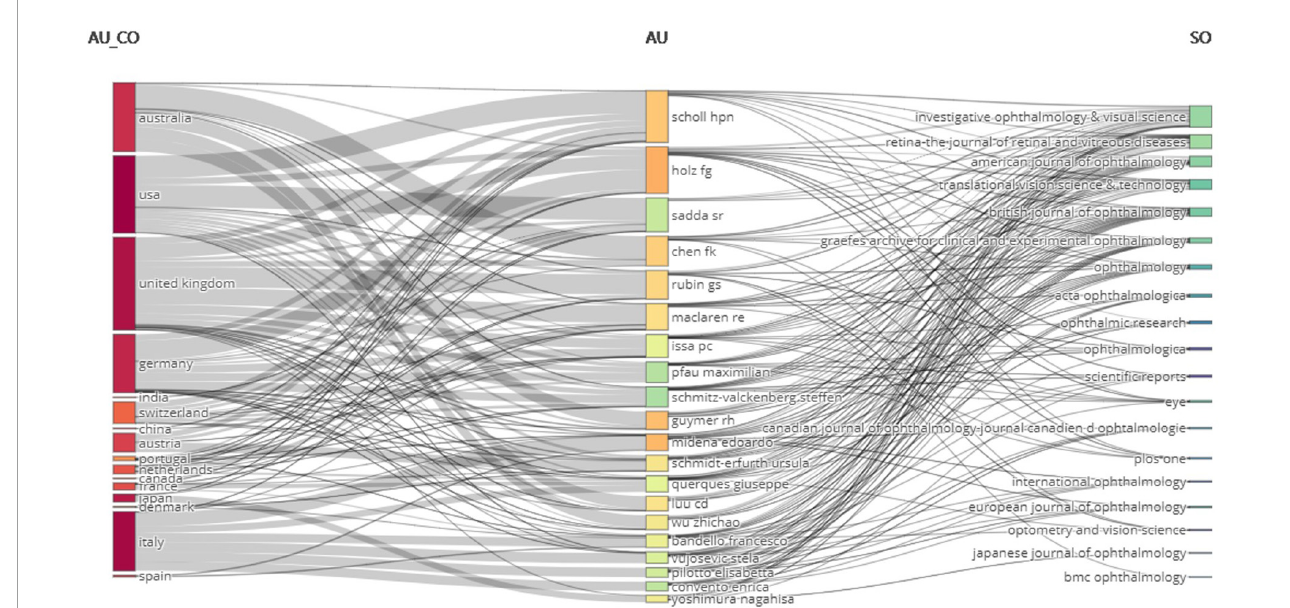
FIGURE10 Relationship among authors, countries, and journals. (Left block) countries; (middle block) authors; (right block) journals. Curve linking them demonstrated the relationship among authors, countries, and journals.